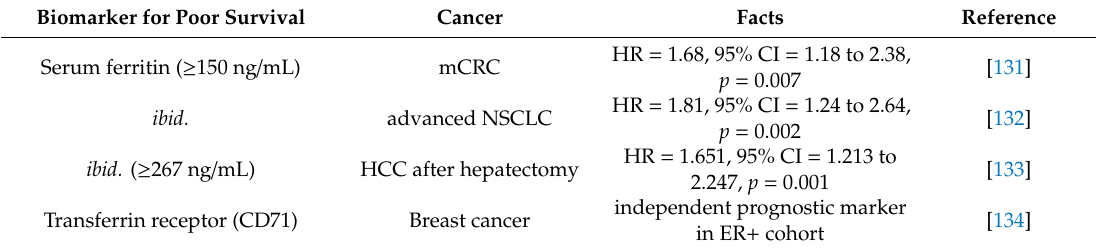
Table 2. Representative human facts on the association of iron and cancer prognosis.